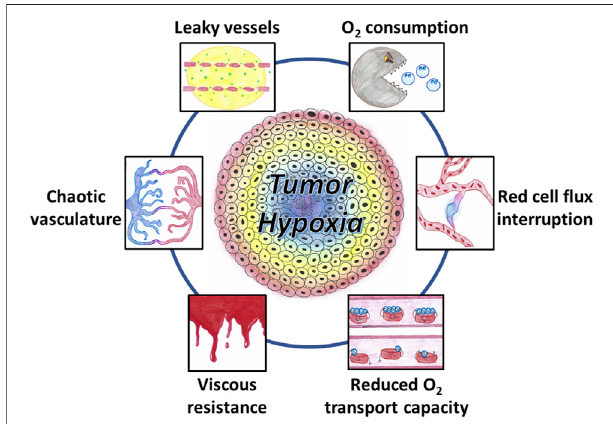
FIGURE 1 | Factors contributing to the occurrence of tumor hypoxia. Thetumorvasculatureischaotic,showingabnormalvasculardensity,contour irregularities, enlarged vessels, and vessels with blind ends. The increased leakiness of immature vessels results in an increased interstitial fl uid pressure. Increased viscous resistance may contribute the vascular stasis. Tumor-associated anemia leads to a reduced oxygen transport capacity. Cycling hypoxia results from transient stasis in fl ow and transient interruption in red blood cell fl ux. Oxygen utilization by a large density of tumor cells with a high degree of metabolic activity and proliferation also contributes to tumor